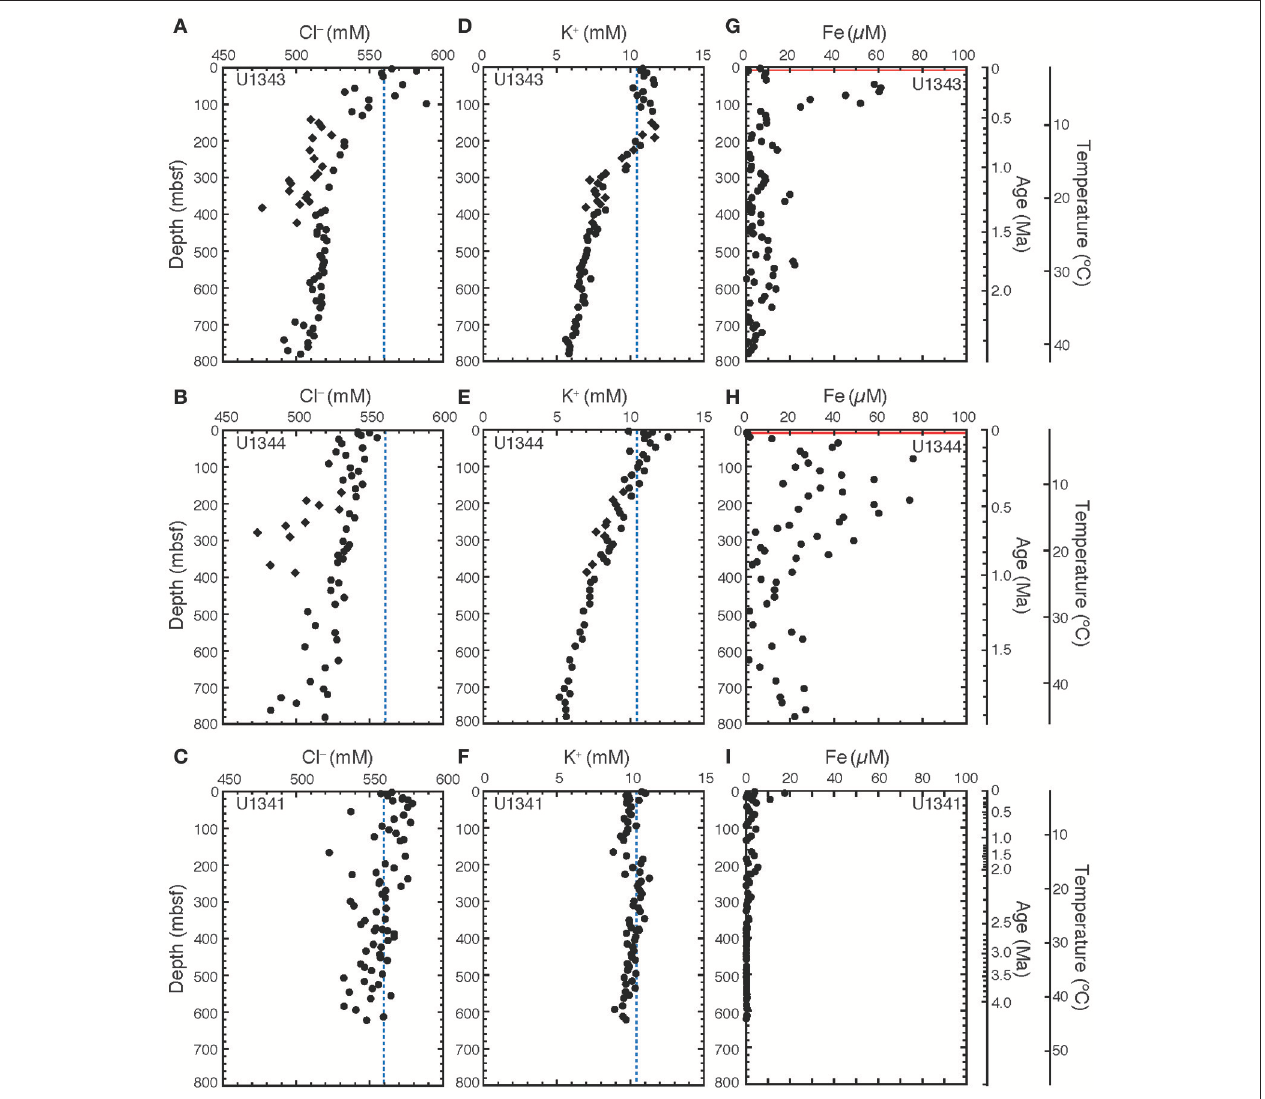
FIGURE 2 | Chemical compositions of porewater at Sites U1341, U1343, and U1344. Vertical profiles of porewater of Cl − for (A) U1343, (B) U1344, and (C) U1341; of K + for (D) U1343, (E) U1344, and (F) U1341; and of Fe for (G) U1343, (H) U1344, and (I) U1341. Diamonds show discrete low Cl − spikes between 150 and 420 mbsf at Sites U1343 and U1344. These data were reported in Takahashi et al. (2011b). The blue dashed lines in (A–F) show Cl − and K + concentrations in seawater. The red lines in (G,H) show the depth of SMTZ (Wehrmann et al., 2011). The age model was based on Horikawa et al. (2015) for Site U1341, Asahi et al. (2014) for Site U1343, and Okazaki et al. (2016) and Takahashi et al. (2011b) for Site U1344. Temperature are estimated by extrapolating the geothermal gradients measured at depths down to 130–140